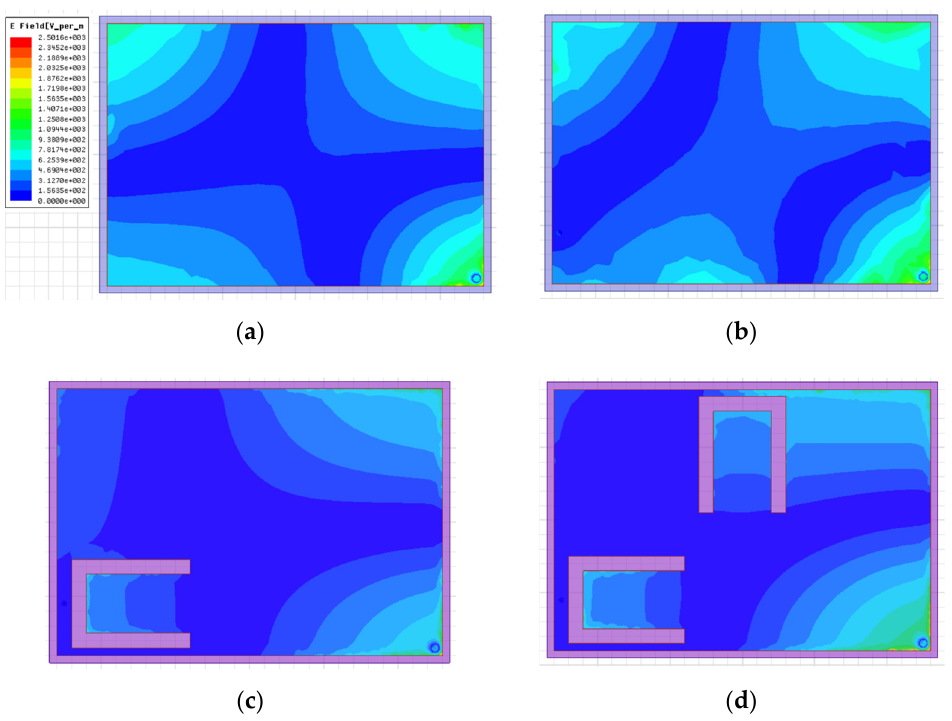
Figure 18. Electric field distribution of the modified antenna at 2.45 GHz with no structure modifications ( a ), after inserting the sorting pin ( b ), after inserting the first U-slot ( c ), and after inserting the second U-slot ( d ).